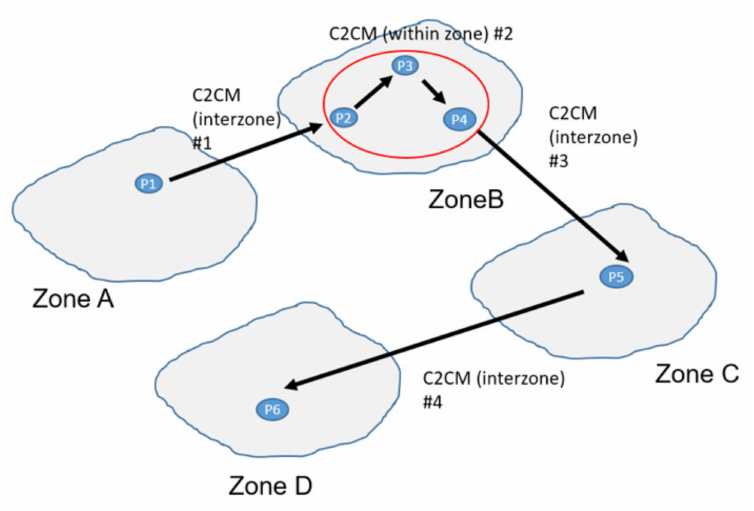
Figure 5. An illustration of the call-to-call movement (C2CM)